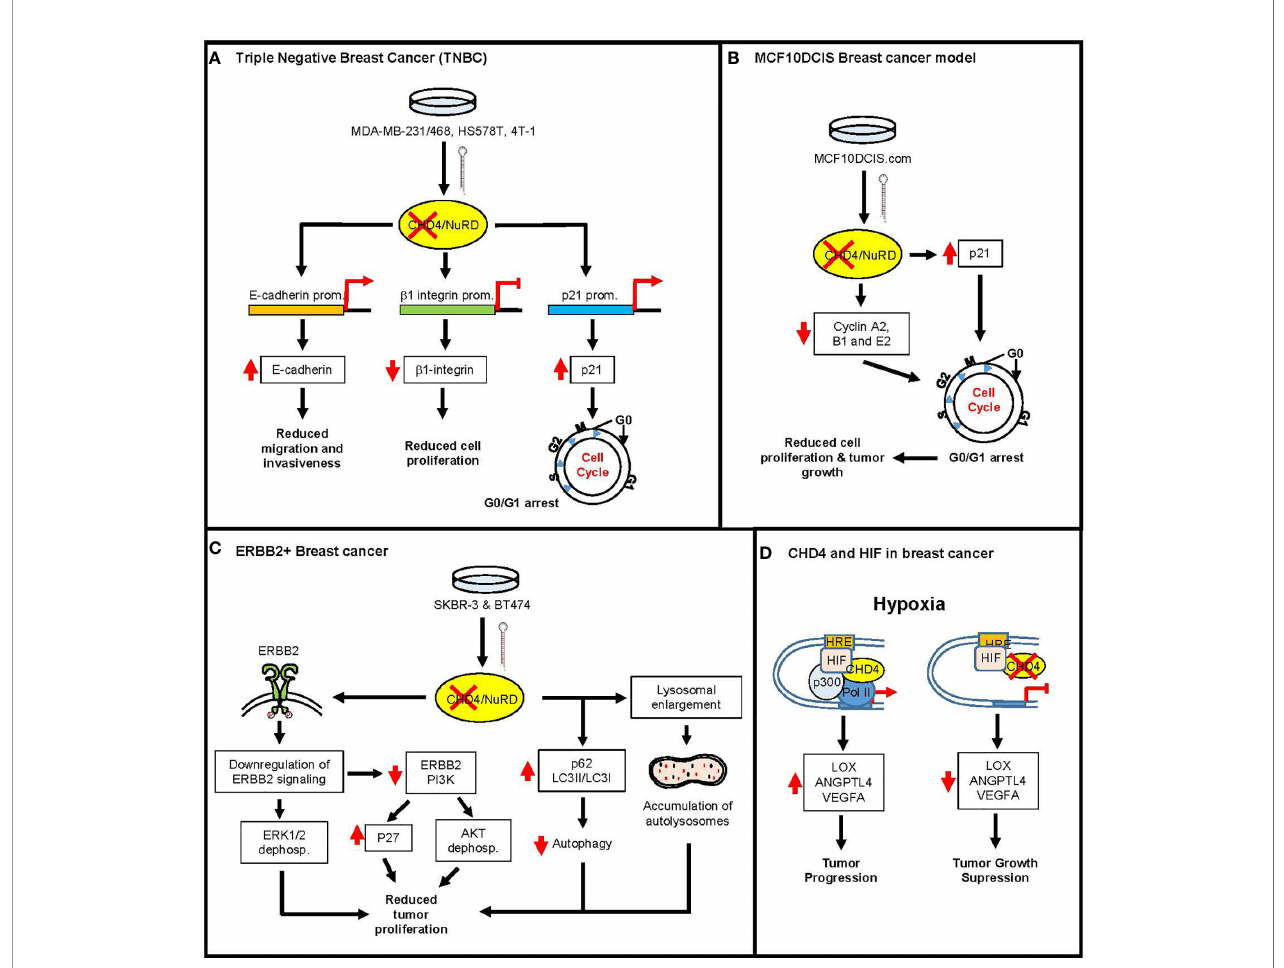
FIGURE 2 | Cellular mechanisms of actions of CHD4 -knock down in different BC models. (A) CHD4 -KD in TNBC cells. Left; MDA-MB-231/468 and HS578T BC cells. Luo et al. (26) reported the E-cadherin transcriptional repression by HDAC/NuRD-dependent deacetylation of its promoter. Knockdown of CHD4 induced hyperacetylation of E-Cadherin promoter, E-cadherin protein accumulation and the subsequent Reduction in migration and invasiveness. Middle; 4T-1 BC cells. Ou- Yang et al, 2019 (27) showed that CHD4 transcriptionally regulates b 1-integrin expression to regulate BC cell proliferation. Furthermore, CHD4 -KD in these cells produces b 1-integrin downregulation and reduced cell proliferation. Right; MDA-MB-231 and HS578T BC cells. Hou et al., 2017 (25) described HDAC1 recruitment to CDK1A (p21) promoter and repression of p21. CHD4 -KD in this case induced accumulation of p21 and G0/G1 arrest. (B) CHD4 -KD in MCF10DCI.com BC cell line. D ’ Alesio et al. (61) reported the effect of the CHD4 silencing in these cells. They found that the down-modulation of CHD4 induced a G0/G1 cell cycle arrest due to a p53-independent p21 accumulation and downregulation of Cyclins A2, B1, and E2, with the subsequent reduction in cell proliferation and mouse-xenograft tumor growth. (C) CHD4 in ERBB2+ BC cells. D ’ Alesio et al. (62) reported the effect of the CHD4 -KD in two ERBB2+ BC cell lines (SKBR-3 and BT474). In these cells, CHD4 regulated both ERBB2 signaling and autophagy. CHD4 silencing in these cells resulted in ERBB2 Tyr 1248 phosphorylation, ERK1/2 and AKT dephosphorylation, and downregulation of both ERBB2 and PI3K protein levels. CHD4 KD also late stages of autophagy, with increased levels of p62, LC3II/I ratio and lysosomal enlargement and an accumulation of autolysomes, everything resulting in reduced tumor proliferation. (D) CHD4 mediates HIF activation in BC during hypoxia. Upon hypoxia (28), CHD4 recruits HIF1/2a to the Hypoxia Response Elements (HRE), together with p300, thus stimulating the transcription of a subset of HIF target genes, such as LOX, ANGPTL4, and VEGFA, promoting tumor progression (left). CHD4 silencing would inhibit this tumor growth